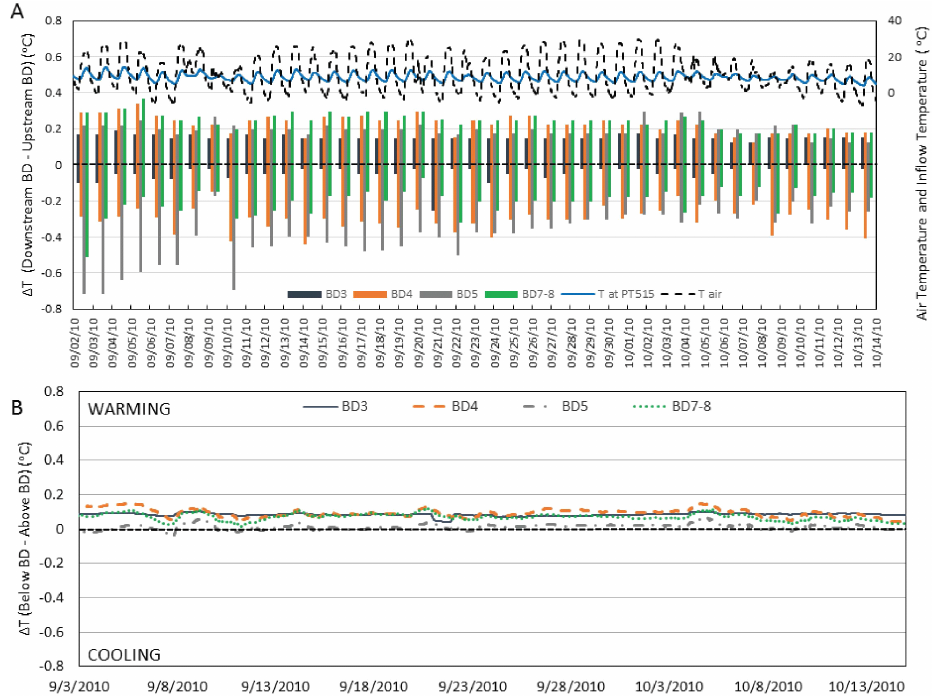
Figure 10. (a) Daily range of temperature differences ( (cid:49)T ) (downstream temperature minus upstream temperature) of each beaver dam (BD) based on 10min temperature records. Beaver dams 7 and 8 were considered to be one complex. The air temperature (blue line) and stream temperature at the inflow (PT515, black-dashed line) illustrate the diurnal patterns; (b) 24h moving average of (cid:49)T